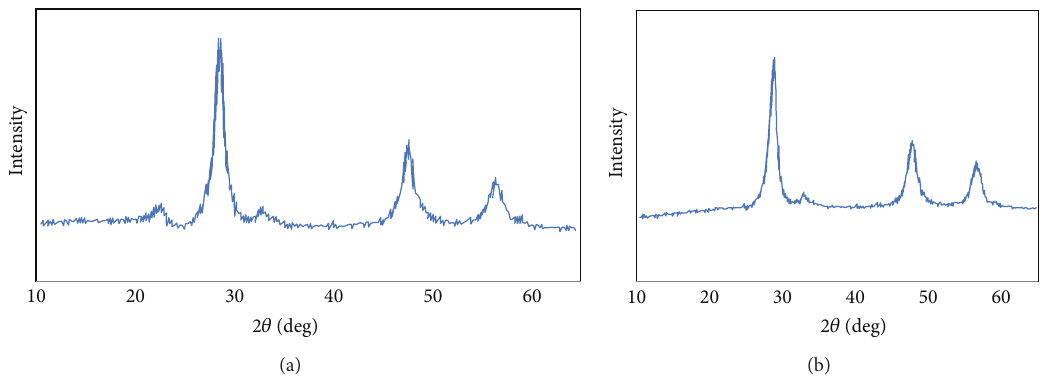
Figure 1: XRD patterns: (a) ZnS@SiO 2 core-shell nanocomposites and (b) bare ZnS nanoparticles.